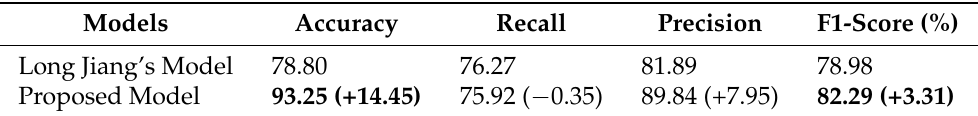
Table 5. Results of performance comparison of the two models. For more precise results, we employ the metric of F1-score with precision and recall.